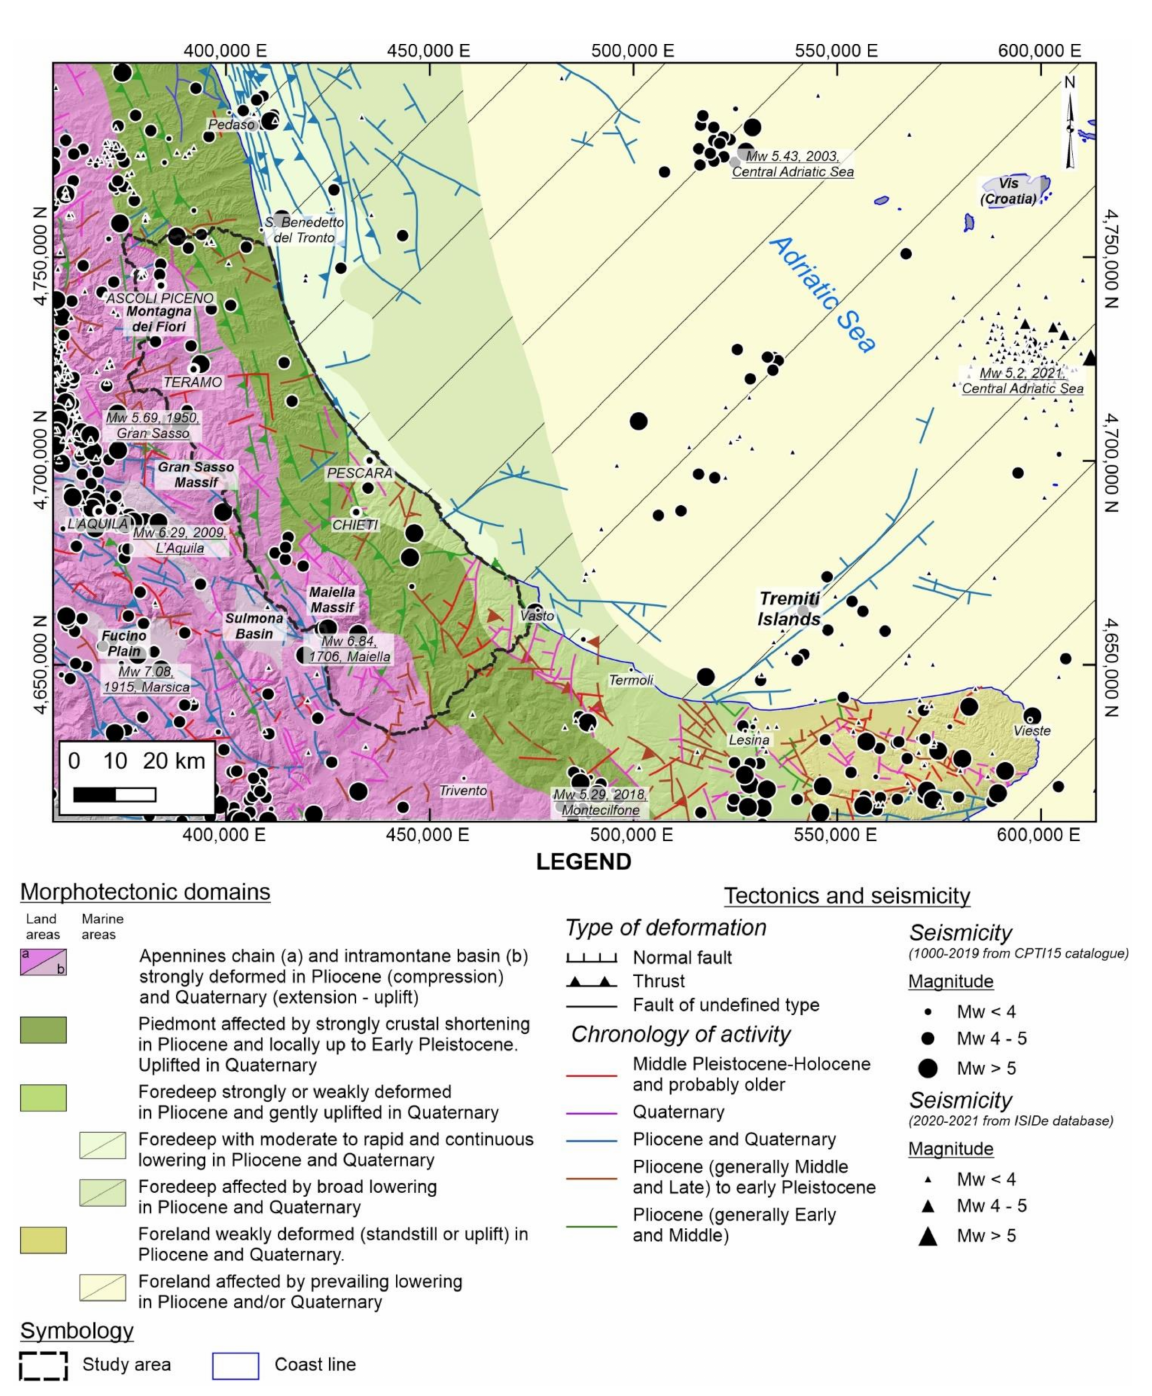
Figure 2. Main morphotectonic domains, tectonics (modified from [89]), and seismicity [99,100] of the central-eastern Apennines and Periadriatic